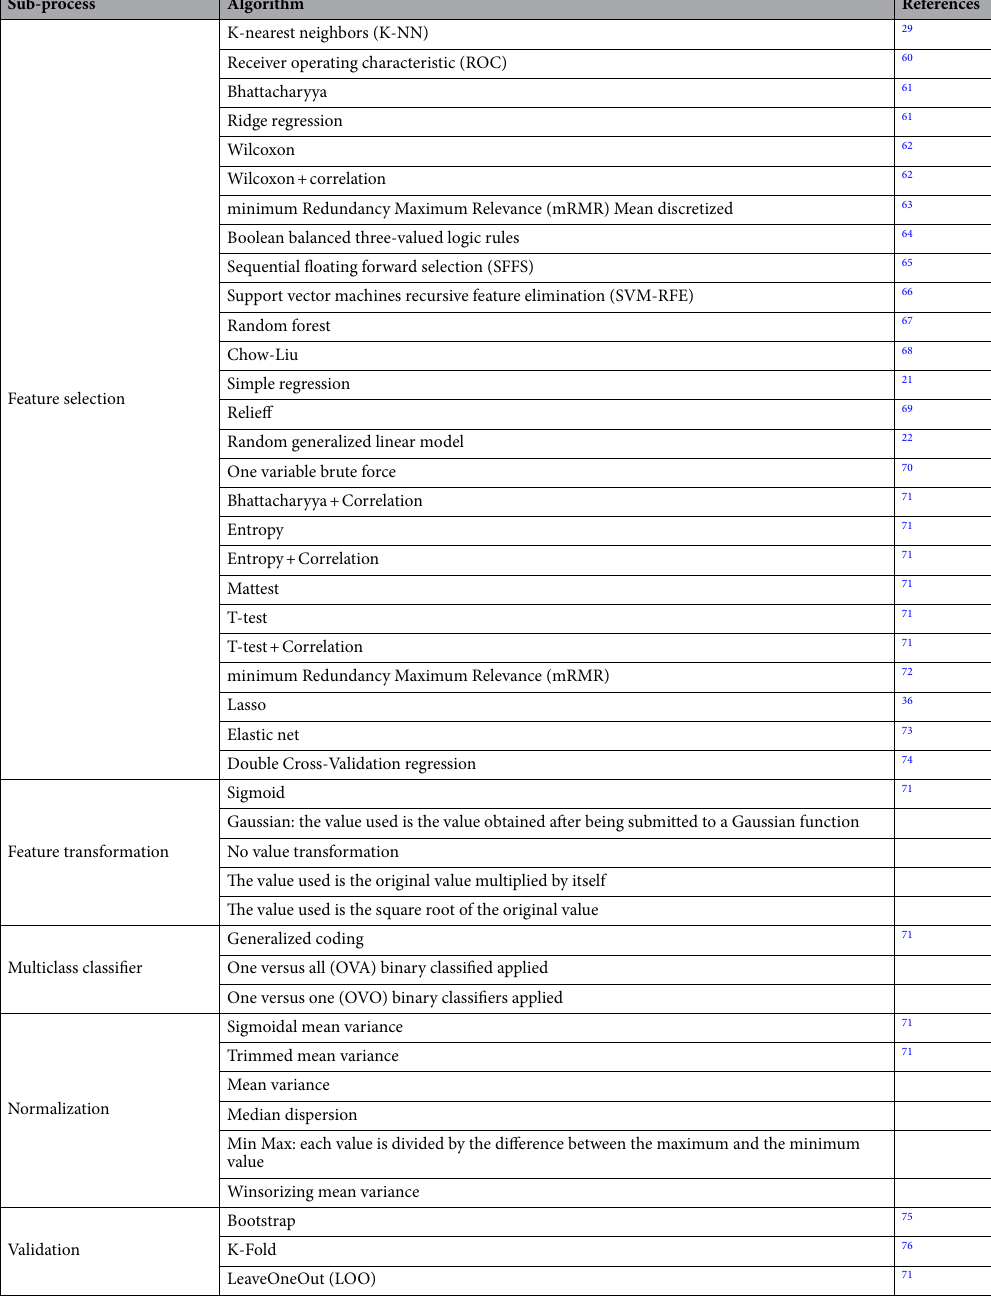
Table 1. Mathematical methods explored during the different processes included in the Data Mining